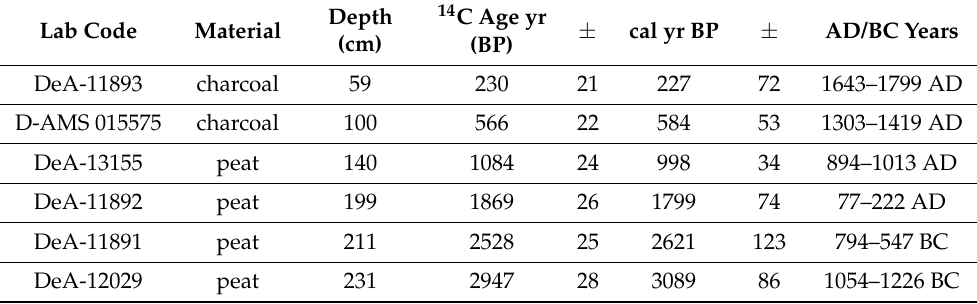
Table 4. 12 AMS data from undisturbing core sequence of the Round